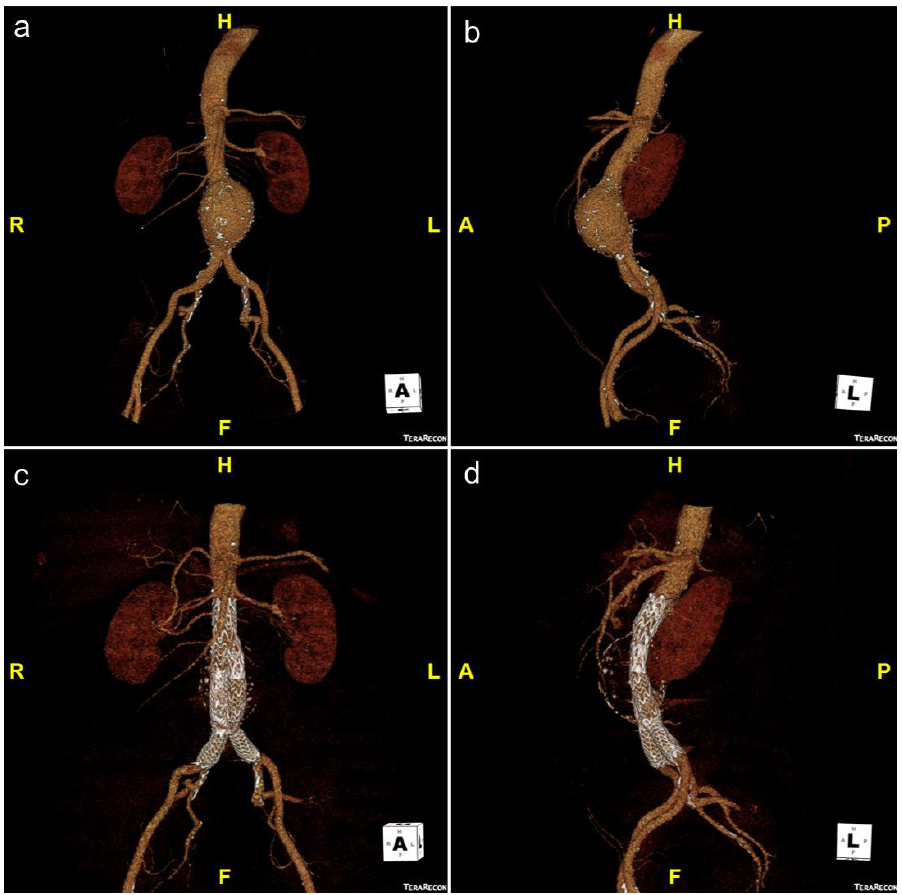
Figure 1. Volume-rendered CT angiogram showing an infrarenal abdominal aortic aneurysm in frontal ( a ) and lateral ( b ) orientations. The patient underwent elective EVAR, which is demonstrated in ( c , d ).